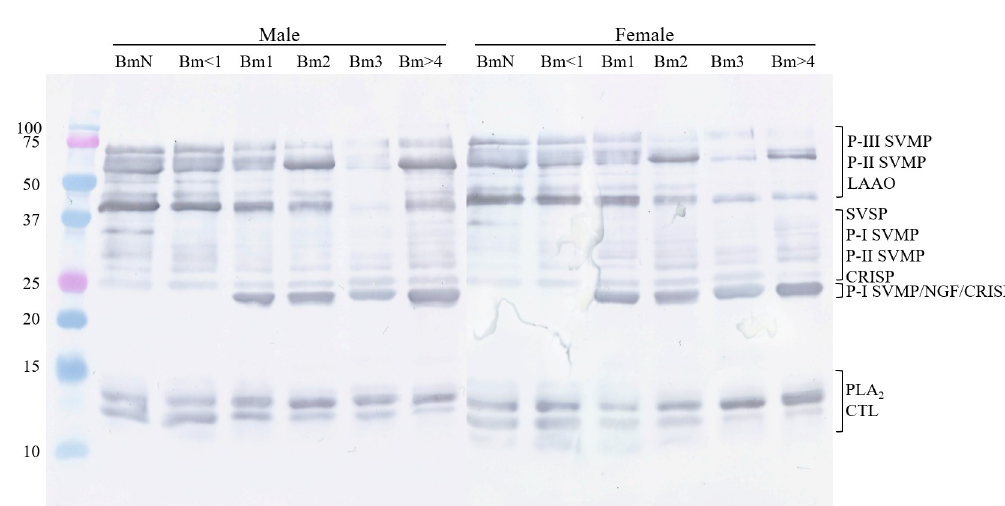
Fig 8. Immunointeraction between B . moojeni venoms and commercial antibothropic serum. The interaction of the proteins in B . moojeni venom with the antivenom produced at Instituto Butantan was assayed by western blotting. The samples were submitted to 1-DE, the proteins were electrotransferred onto a PVDF membrane, and incubated with the antibothropic serum. SVMP: snake venom metalloprotease; LAAO: L-amino acid oxidase; SVSP: snake venom serine protease; CRISP: cysteine-rich secretory protein; NGF: nerve growth factor; PLA 2 : phospholipase A 2 ; CTL: C-type lectin.